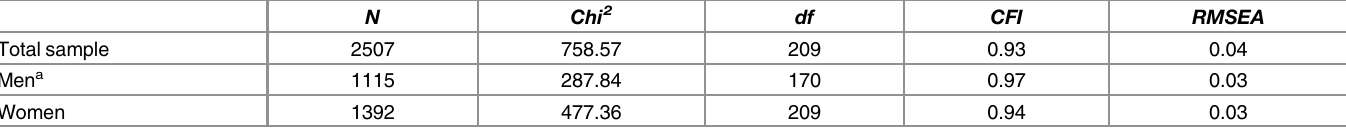
Table 2. Fit indices of the confirmatory factor analysis for the Self Harm